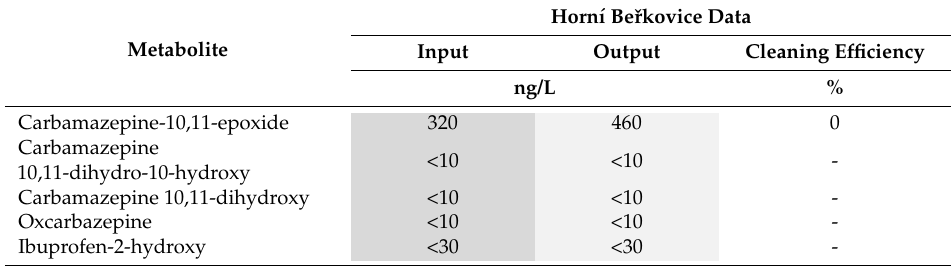
Table 5. Single measure of metabolites and additional pharmaceuticals at the Horn í Beˇrkovice